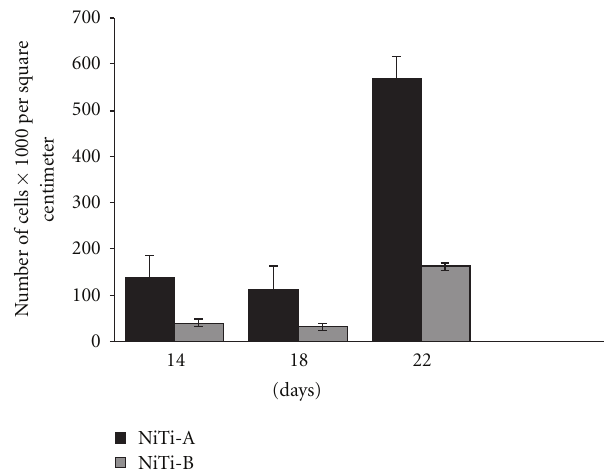
Figure 12: E ffi ciency of MSC proliferation on the NiTi-A and NiTi- B specimens. Cell counting in the Goryaev chamber.